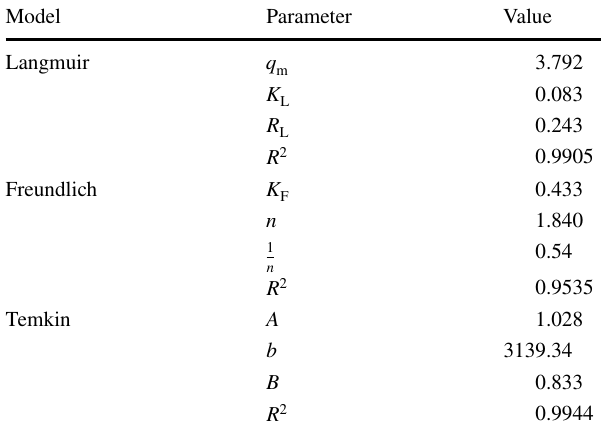
Table 1 Langmuir, Freundlich and Temkin isotherm constants for the adsorption of Cr(VI) ion unto groundnut shell